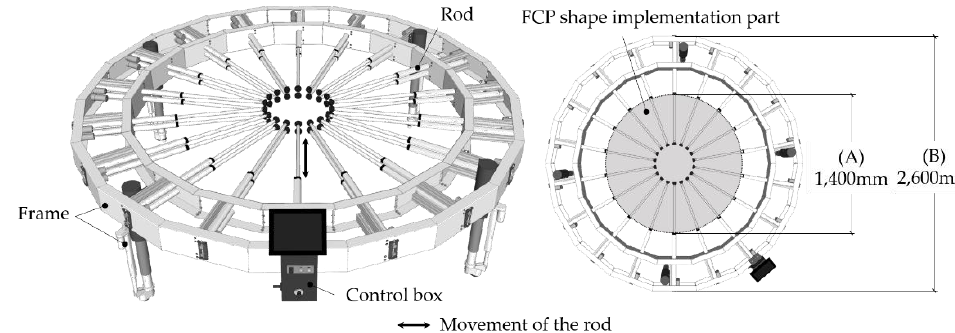
Figure 11. Side mold control equipment.